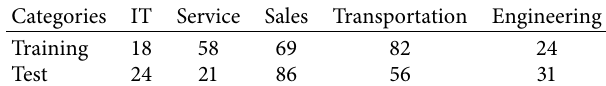
Table 1: Training set.